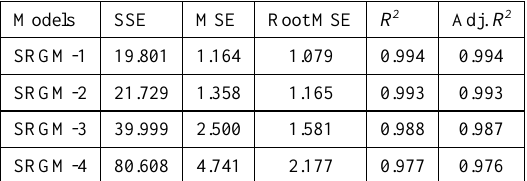
Table 2. Comparison results for data set